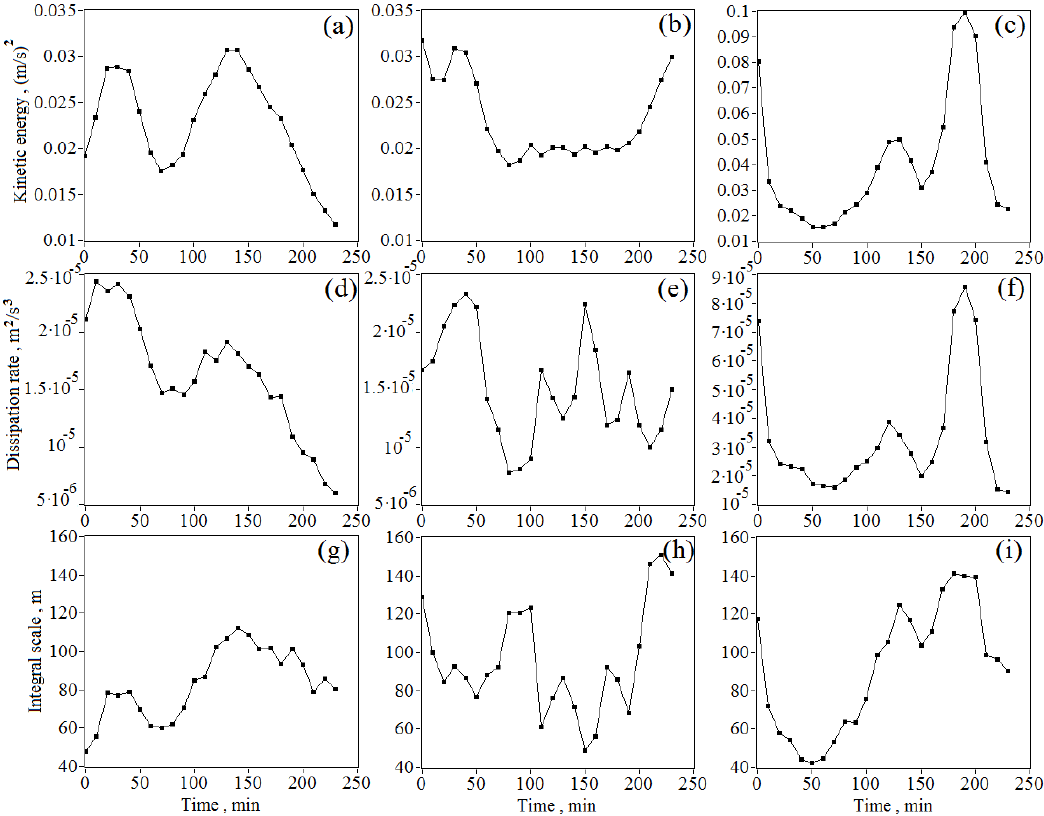
Figure 6. Temporal variations of the kinetic energy of turbulence ( a – c ), the dissipation rate ( d – f ), and the integral scale of turbulence ( g – i ) as obtained from measurements by the StreamLine lidar at 22:00 LT on 20 July 2016 ( a , d , g ), 22:00 LT on 21 July 2016 ( b , e , h ), and 22:30 LT on 22 July 2016 ( c , f , i ) at heights of 307 m ( a , d , g ), 254 m ( b , f , h ), and 317 m ( c , f , i